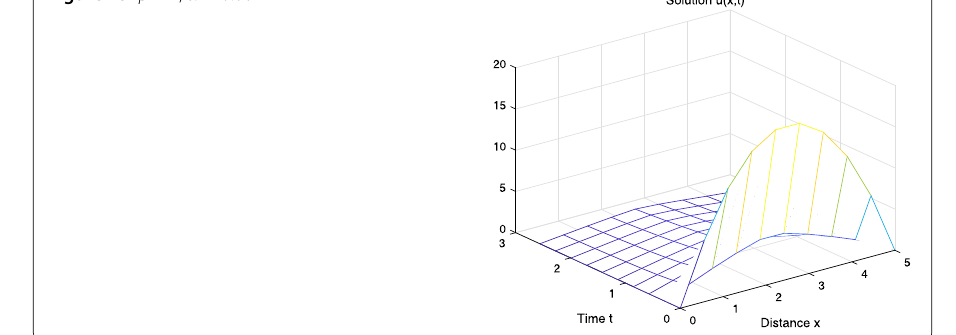
Figure 13 p = 4, α = 0.66